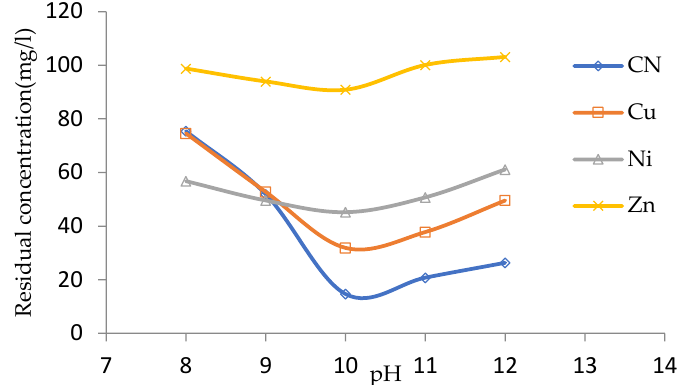
Figure 3. Effect of pH on contamination removal efficiency at EC process. Based on Equations (4) and (5), as the iron anode begins to react and oxidize, the solution pH begins to rise, and hydroxyl ions are produced. Then, based on Equations (6) and (7), cyanide in the solution at high pHs in the presence of hydroxyl ions is oxidized to cyanate ions (CNO - ) and then to carbonate or carbon dioxide (CO 2 ) and nitrogen (N 2 ). Consequently, the cyanide ions are removed from the solution by oxidation and production of secondary compounds.